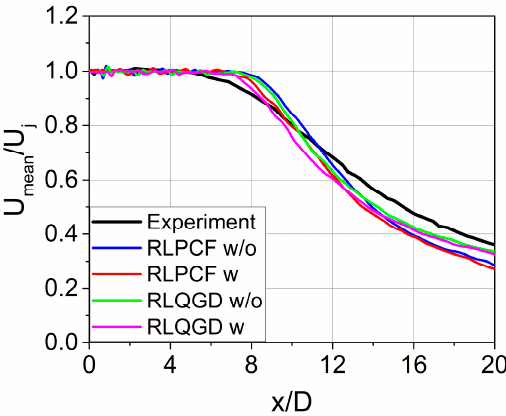
Figure 5. Axial distribution of the mean velocity field.